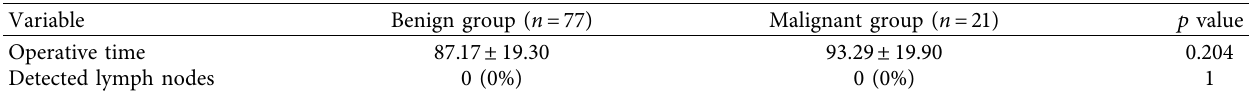
Table 2: Operative findings.